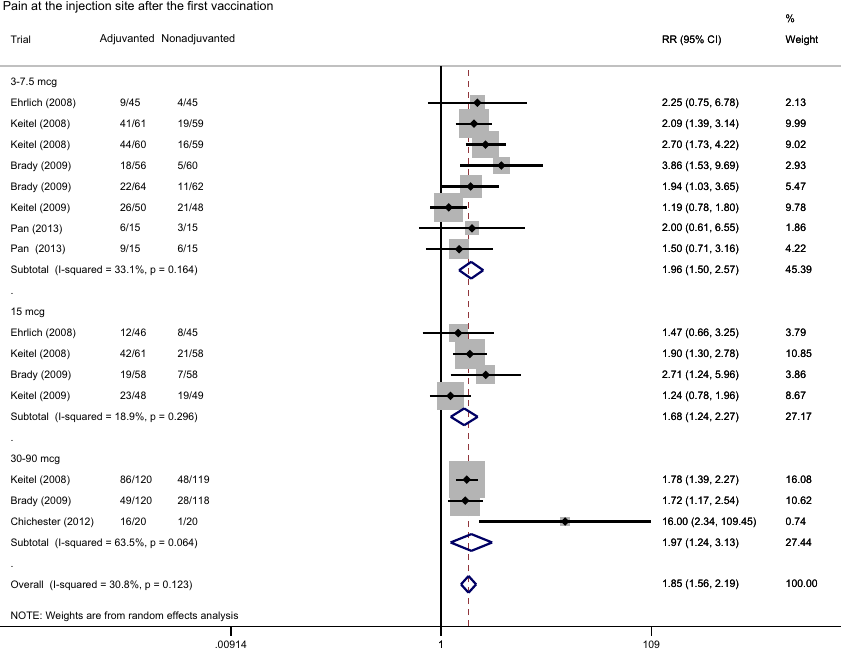
Figure 4. Forest plot showing the risk ratio of pain/tenderness at the injection site during the 7 days after the first dose of H5N1 vaccines in participants who received aluminum-adjuvanted vaccines versus non-adjuvanted